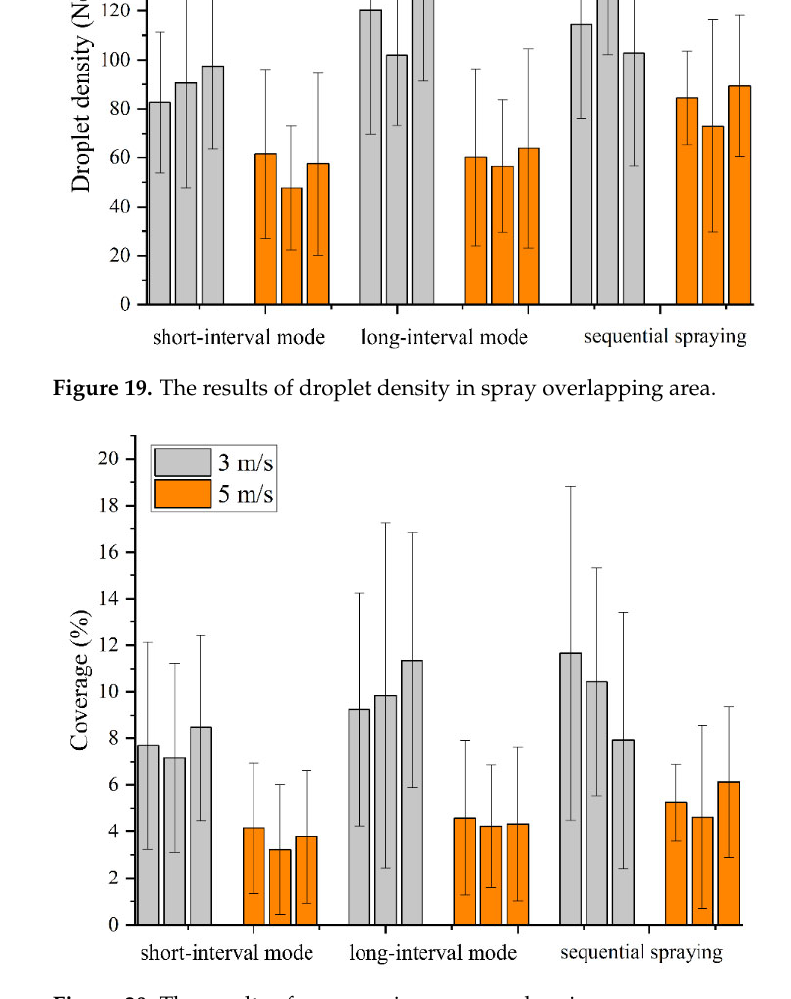
Figure 20. The results of coverage in spray overlapping area.